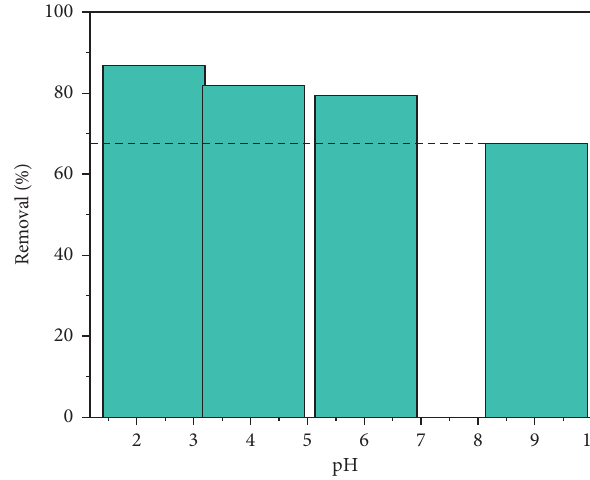
Figure 4: pH solution effect on the RBB adsorption.